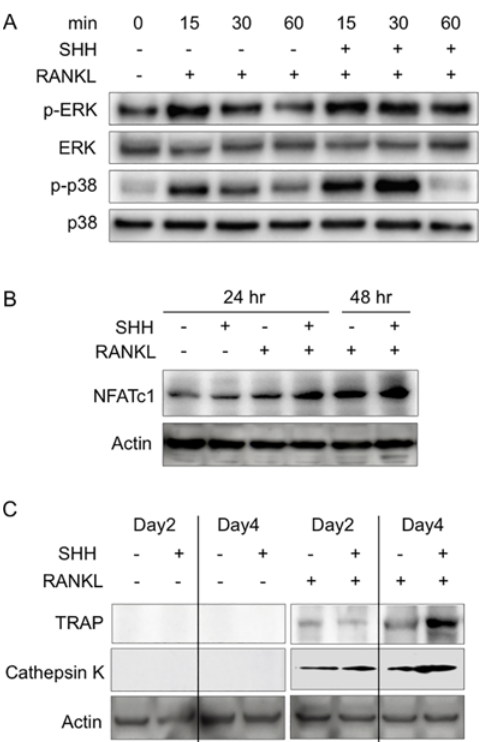
Fig 4. Effects of SHH on MAP kinase activity and osteoclast differentiation. ( A ) Detection of p-ERK, ERK, p-p38, and p38 by immunoblot analysis after RANKL (50 ng/ml) in murine macrophage RAW264.7 cells with or without SHH (500 ng/ml). ( B ) Immunoblot analysis of NFATc1 in RAW264.7 cells 0 – 48 h after RANKL (30 ng/ml) or SHH (500 ng/ml) treatment. ( C ) The mature osteoclast-differentiated cells were treated with SHH (500 ng/ml) or RANKL (30 ng/ml). Protein expression of TRAP and Cathepsin K was analyzed by immunoblot analysis. Similar results were obtained in three different